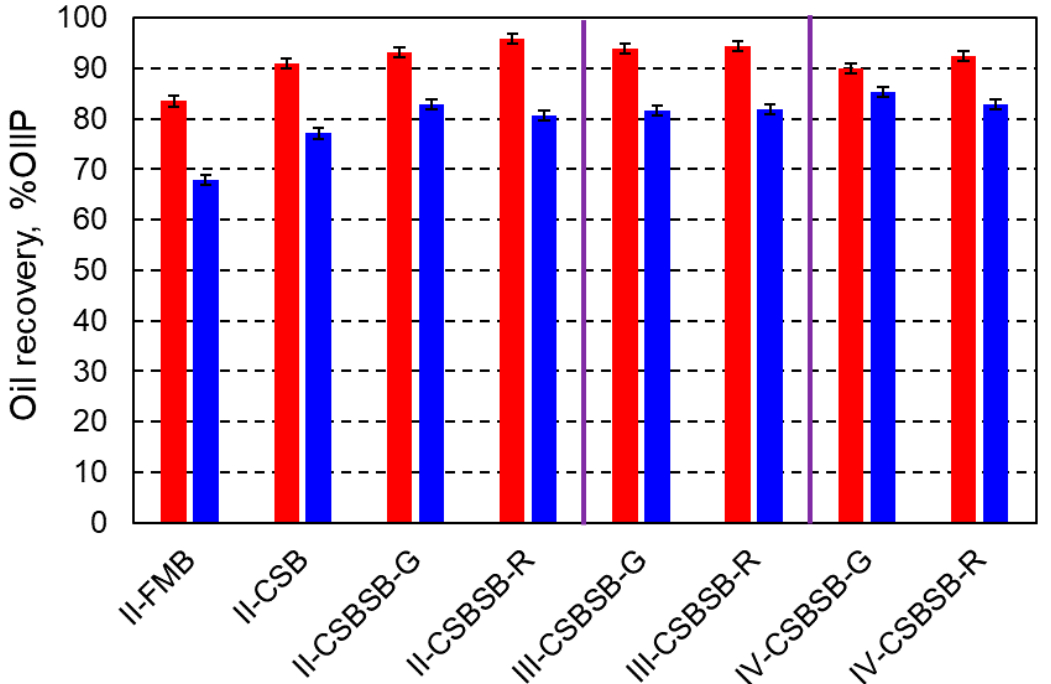
Figure 7. The ultimate oil recovery obtained with various injection sequences of FMB, CSB, CSBSB-G and CSBSB-R. In this figure, ‘II’ corresponds to the secondary injection, ‘III’—to the tertiary injection, and ‘IV’—to the quaternary injection of the corresponding solutions. The red columns in the figure correspond to experiments conducted at 70 °C while the blue columns correspond to 23 °C experiments. The error bars represent the inaccuracy of measured produced volumes and not the experimental repeatability although select experiments were repeated to confirm >97% reproducibility of the re- sults.